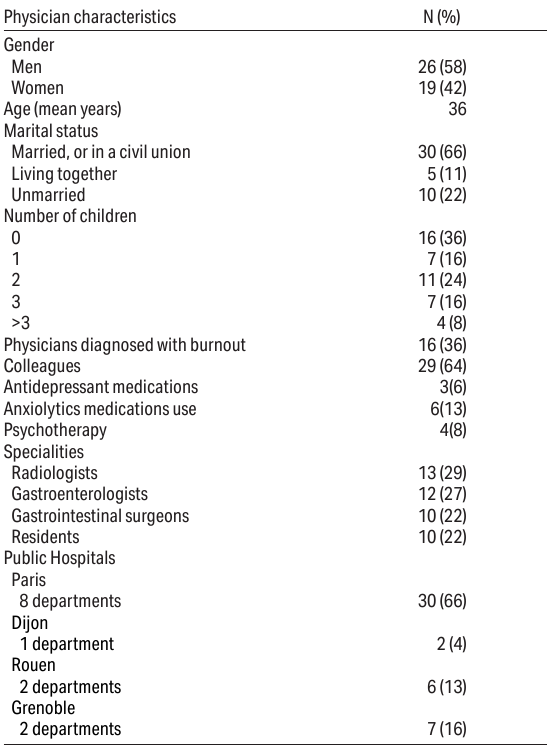
Table 3. Summary of participants’ characteristics. Physician